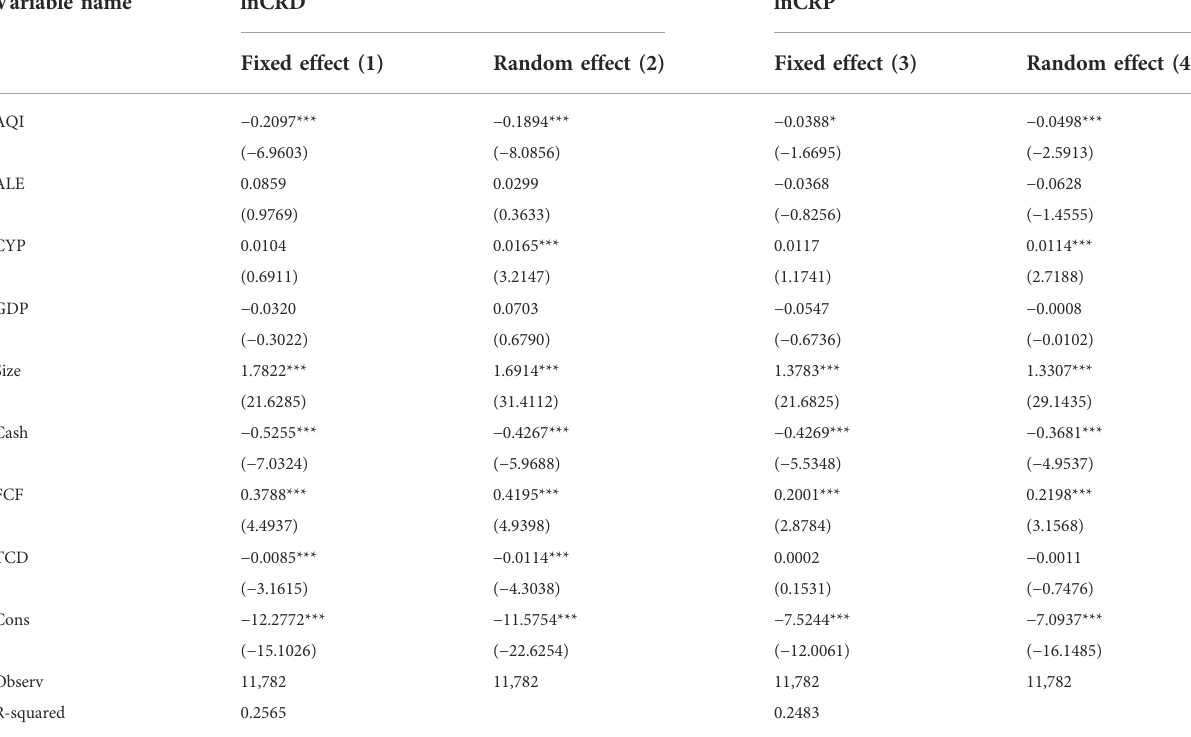
TABLE 3 Benchmark regression